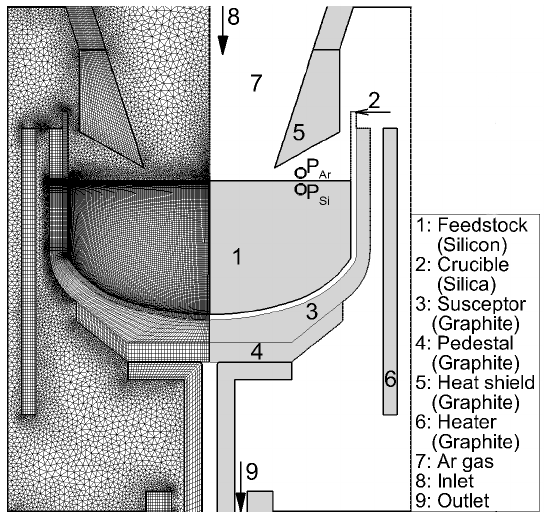
Figure 3. Geometry of the CZ-Si crystal growth. Reproduced with permission from X. Liu, B. Gao, S. Nakano, K. Kakimoto, Journal of Crystal Growth; published by Elsevier, 2017 [20].